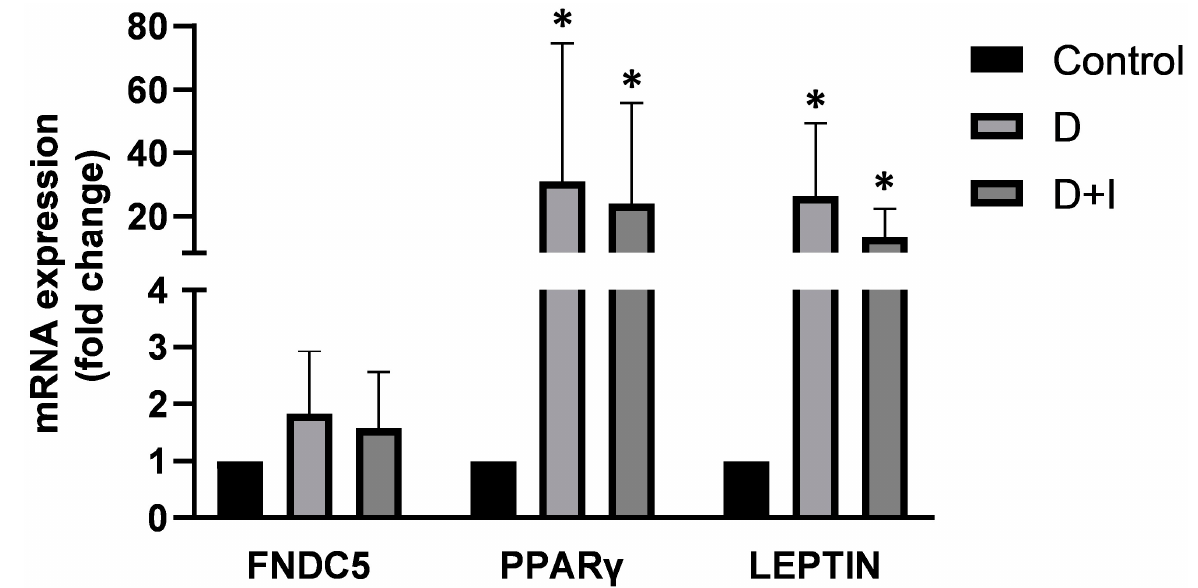
Figure 4. The figure shows the mRNA expression (fold change) of FNDC5, PPAR γ and LEPTIN in two cell populations relative to the Control (ASCs pre-differentiated): ASCs differentiated into adipogenic lineage (D) and ASCs differentiated into adipogenic lineage and treated with 150 ng/ µ L of Irisin (D + I). The gene expression of PPAR γ and LEPTIN was increased in D and D + I compared to the control (* p value ≤ 0.05), while no significant change was observed in FNDC5 expression between the three cell populations. Actin was used as a housekeeping gene.